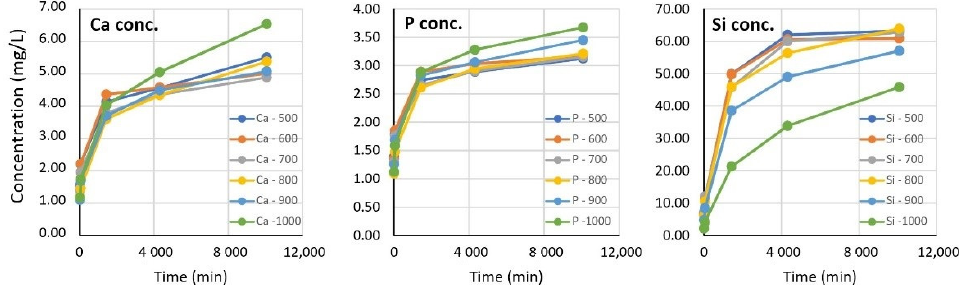
Figure 5. Dynamic change in concentration of the leached components as a function of time and heating temperature.